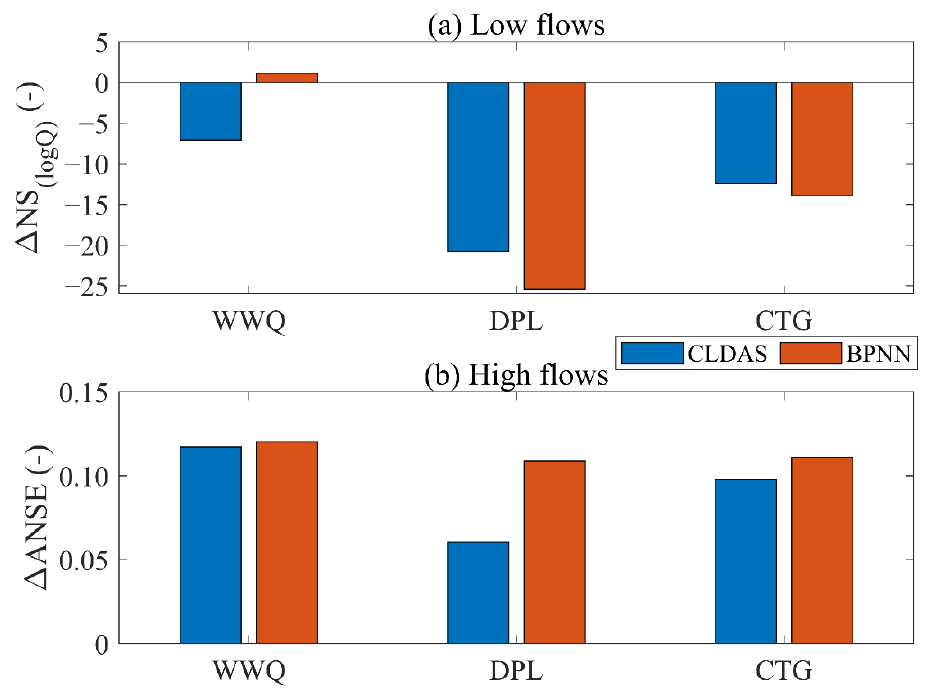
Figure 9. Differences ( ∆ NS ( logQ ) , and ∆ ANSE ) between NS ( logQ ) and ANSE performance scores were obtained before and after the assimilation of soil moisture for the three selected basins. While ( a ) NS ( logQ ) was well suited for highlighting the performance in the reproduction of low flows, ( b ) ANSE was used for characterizing the agreement of high